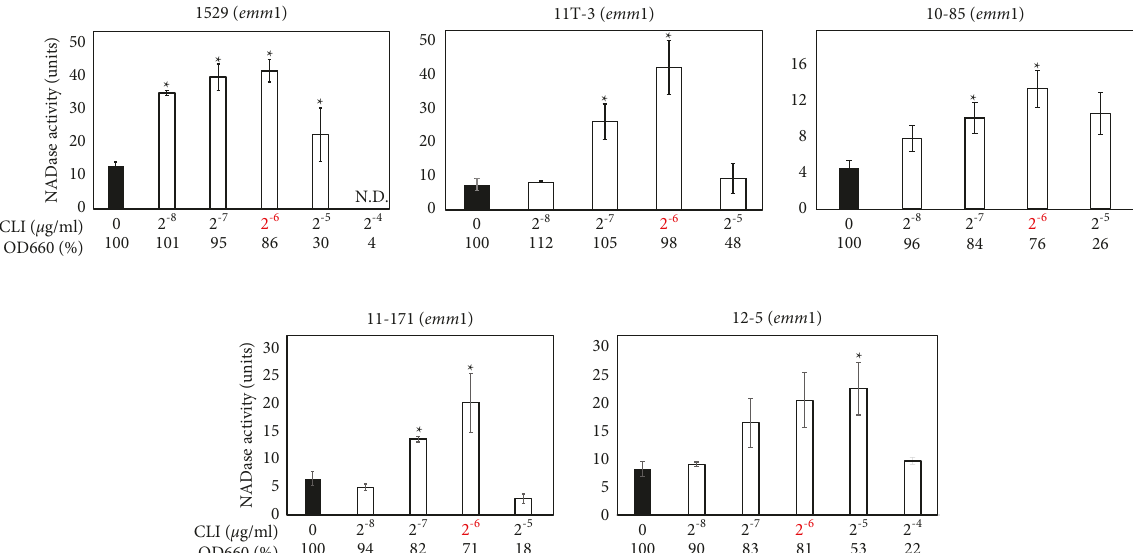
Figure 1: Extracellular NADase activity in emm 1-type strains cultured with clindamycin (CLI). One unit of NADase activity was defined as the amount ( μ g) of β -NAD cleaved per hour per μ L of culture supernatant, as described previously [10]. The OD 660 of overnight culture with CLI (2 − 8 to 2 − 4 μ g/ml) is shown by a percentage (%) of that without CLI (0 μ g/ml). The maximum CLI concentration that did not suppress the bacterial growth to less than 50% of that without CLI is shown in red, which was 2 − 6 μ g/ml in strains 1529, 11T-3, 10–85, and 11–171, and 2 − 5 μ g/ml in strain 12–5. At least three independent experiments were performed. Error bars indicate the standard errors of the means. Significant increases in extracellular NADase activity by CLI treatment when compared with that without CLI treatment, shown by the black bar, are marked with asterisks ( ∗ p < 0 . 05 using Student’s t